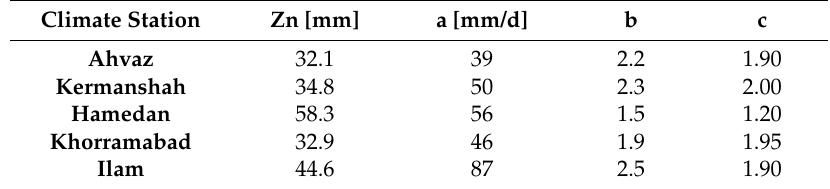
Table 5. Optimized parameter values of the SM2RAIN Equations (1)–(3) at the various climate stations. Climate